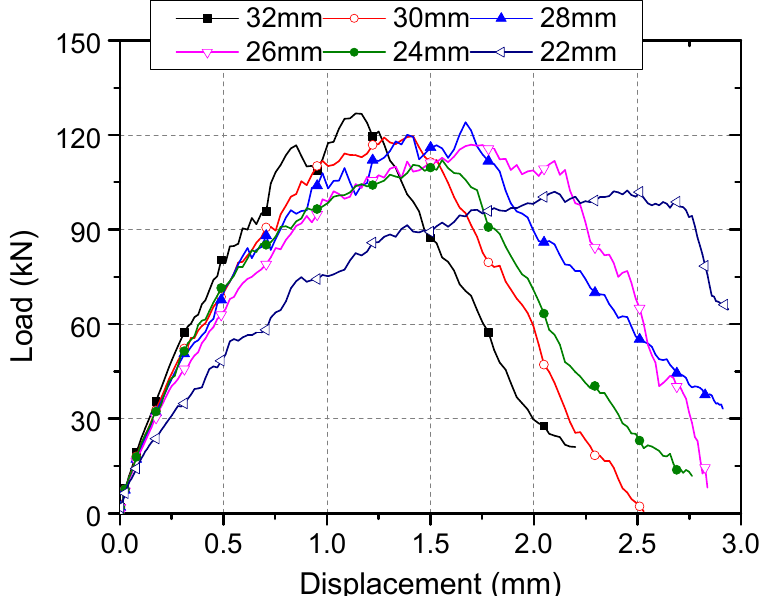
Figure 14. Results of models with different sizes of stud head.